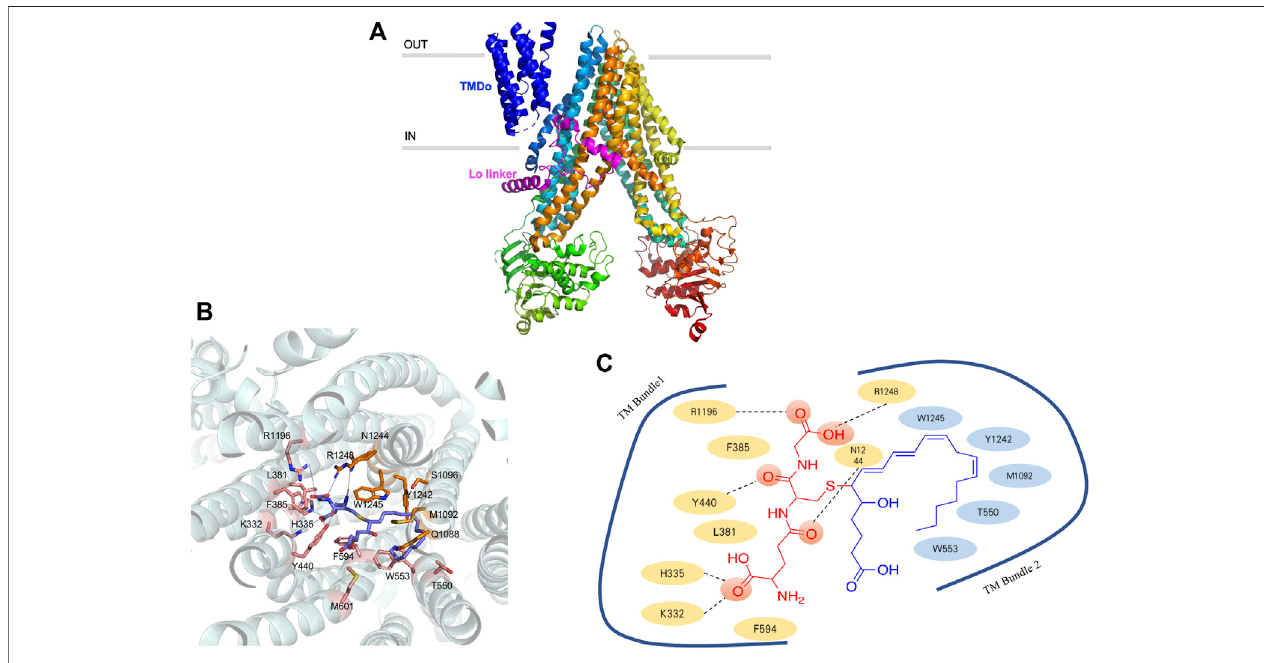
FIGURE 3 | Ribbon representation of the ABCC1 structure (A) ribbon representation of the ABCC1 structure, with the TMDo colored dark blue and Lo linker coloredpurple (B) three-dimensionofABCC1 bindingwithLTC4,theproximityresidues,and theirinteractionswithLTC4areannotatedinthepicture (C) thesystematic illustration of ABCC1 binding with